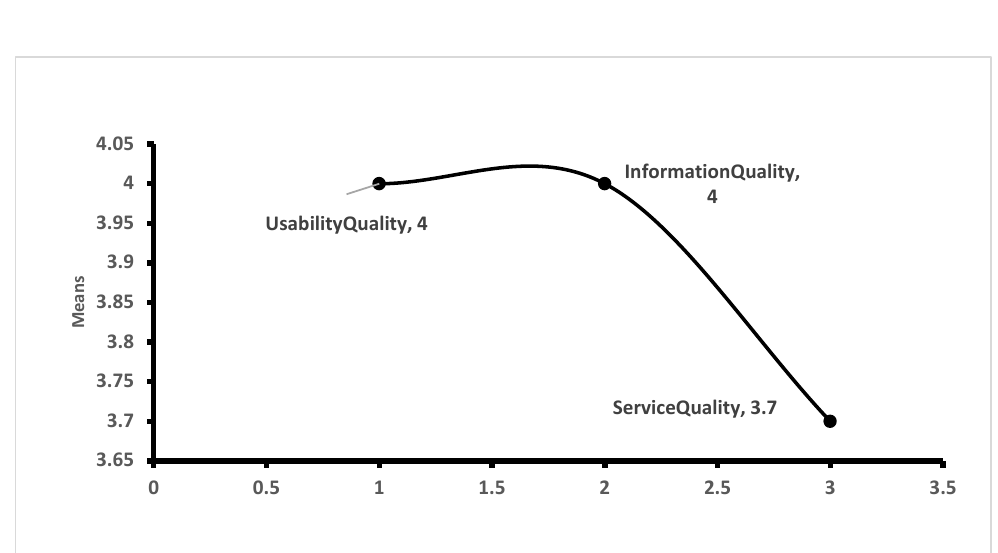
Fig. 22. Website Quality Attributes